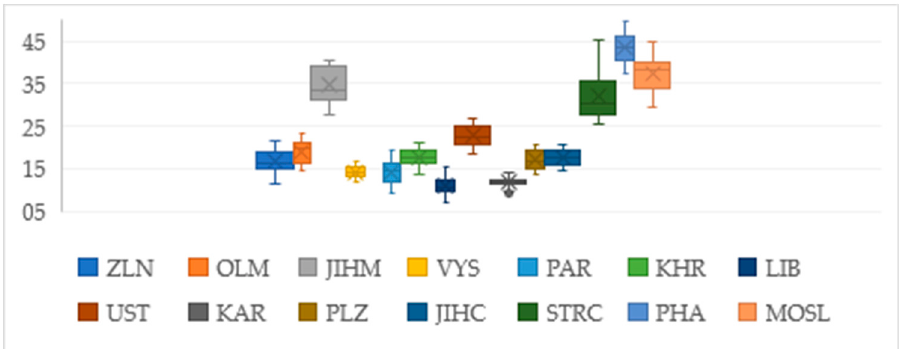
Figure 4. Boxplot of the number of people employed in the Health and Social Care sector in the regions of the Czech Republic in thousands of people (median for 1993–2016).